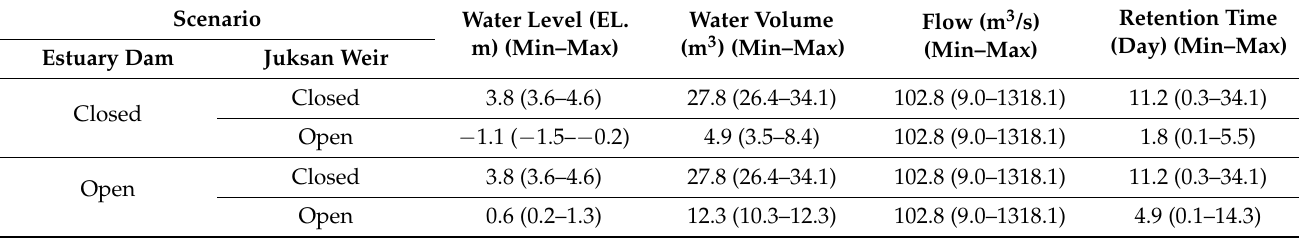
Table 9. Simulations of water level and retention time in the Juksan Weir section according to the operating conditions of the Juksan Weir and estuary dam (averaged from June to September